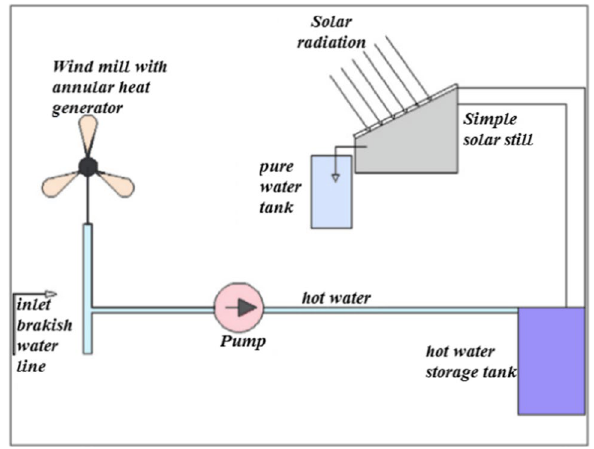
Fig. 35 Producing freshwater by combining solar and wind systems (Moh’d A et al.